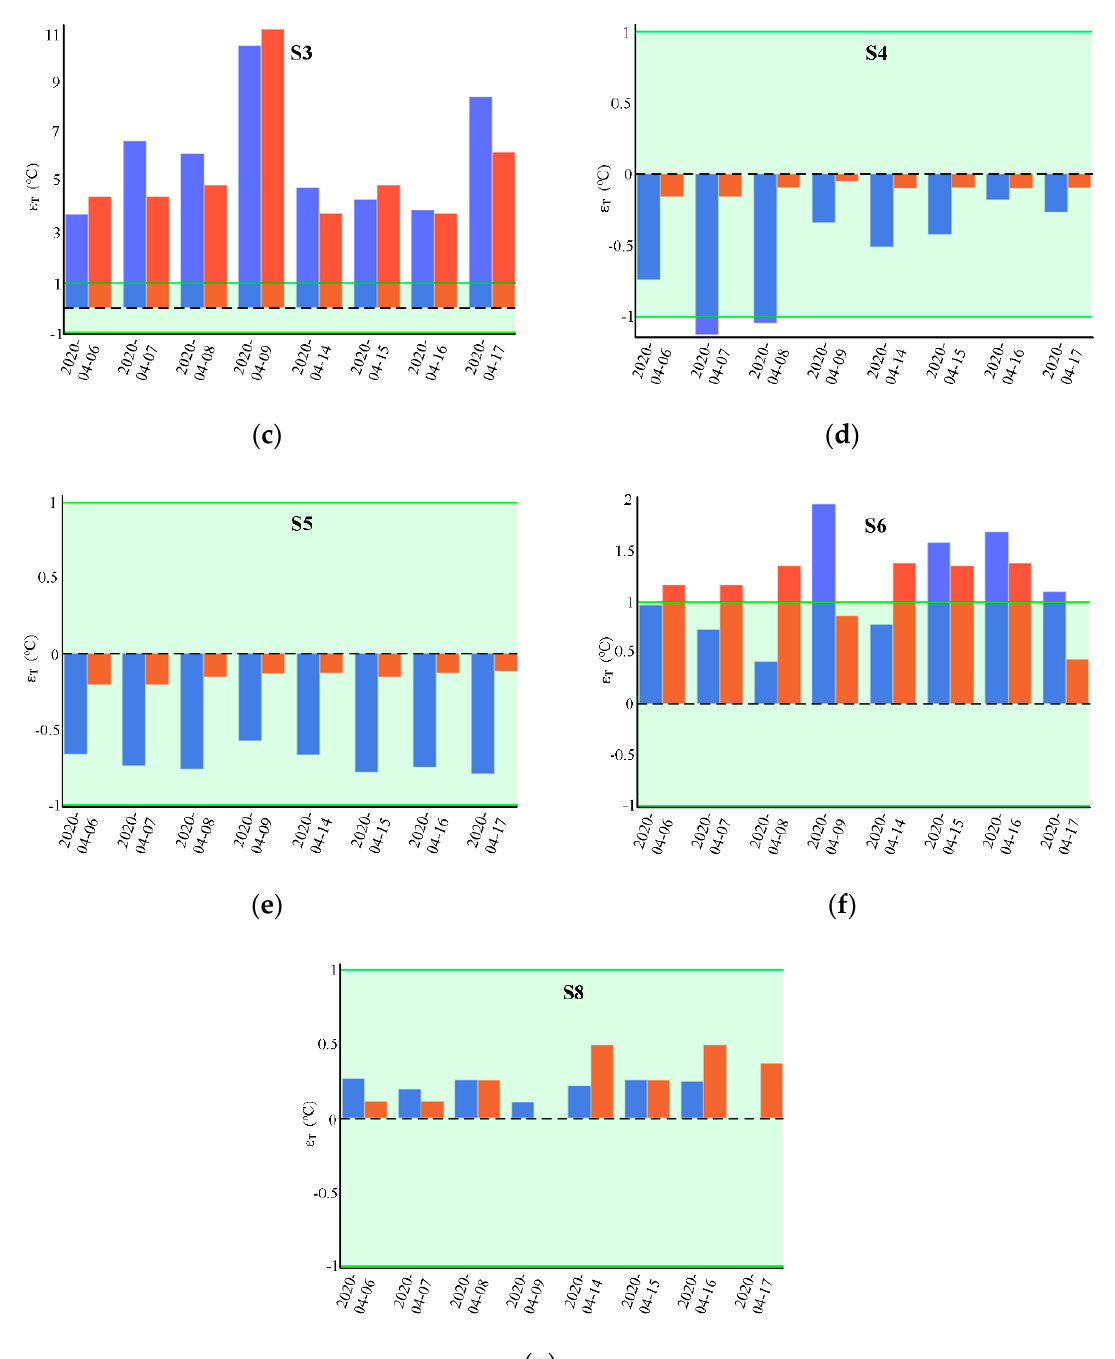
Figure 13. Temperature error in regard to its set point of the different spaces to refrigerate. ( a – g ) Error in each space.